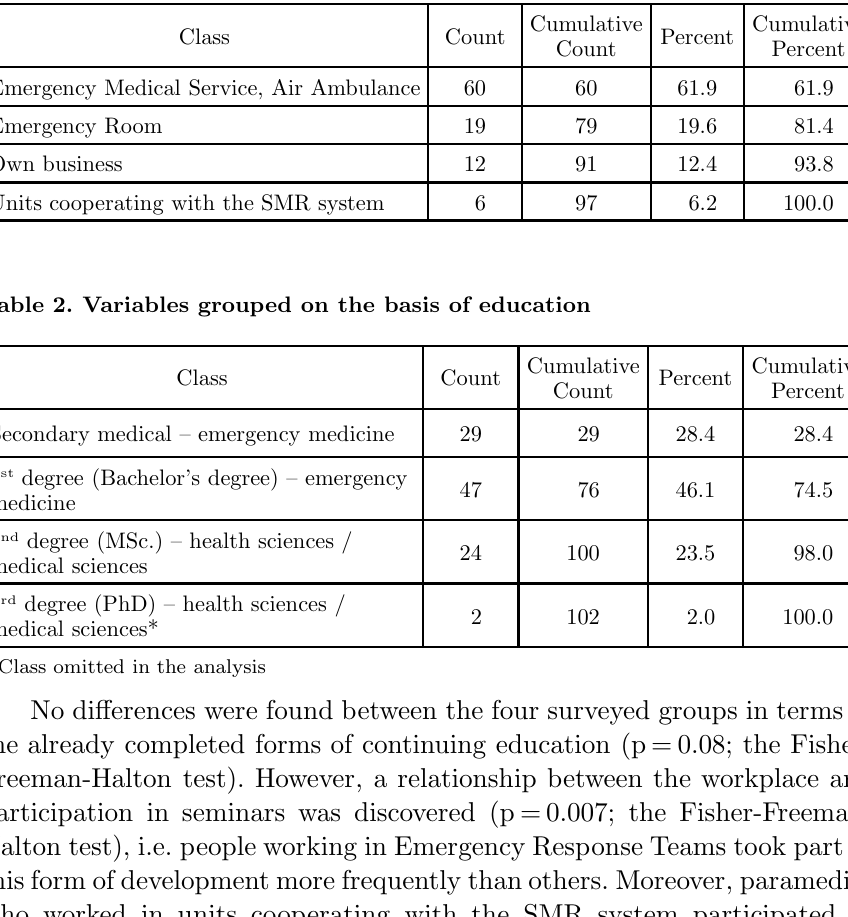
Table 1. Variables grouped on the basis of workplace